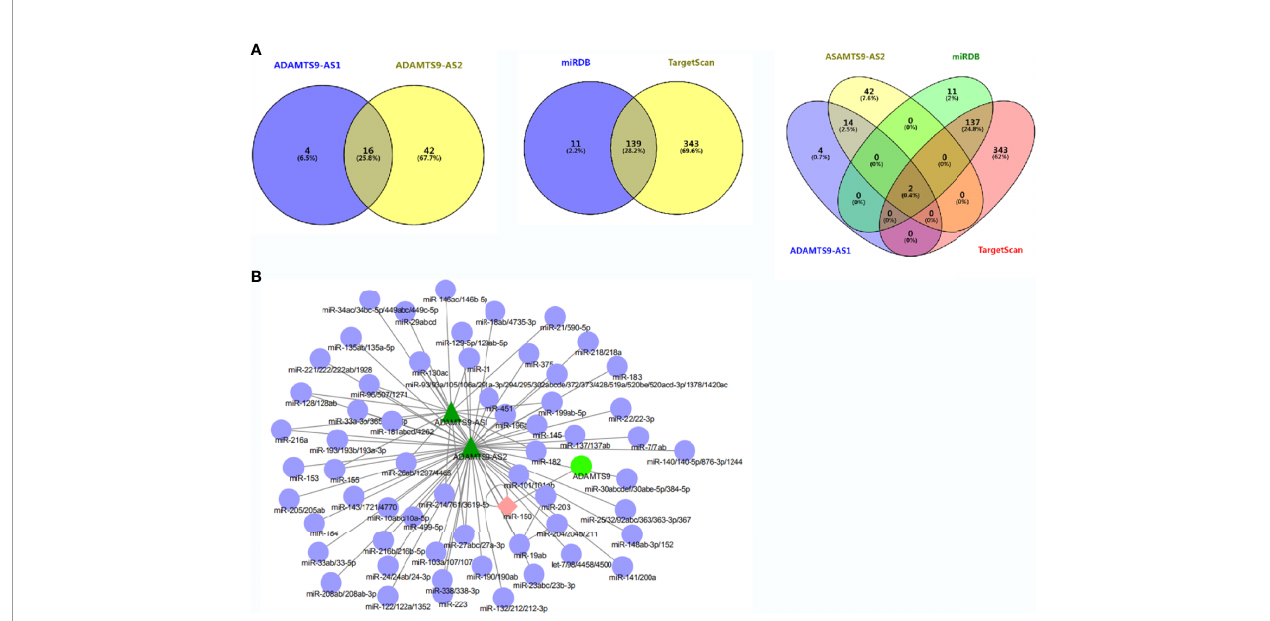
FIGURE 4 | Overlapped differentially expressed genes from the intersection analysis. (A) Two miRNAs (miR-144-5p and miR-150-3p) combined with ADAMTS9-AS1/ ADAMTS9-AS2/ADAMTS9 were analyzed. (B) The network interaction relationship of ADAMTS9-AS1/ADAMTS9-AS2/miR-150/ADAMTS9 is analyzed by Cytoscape.